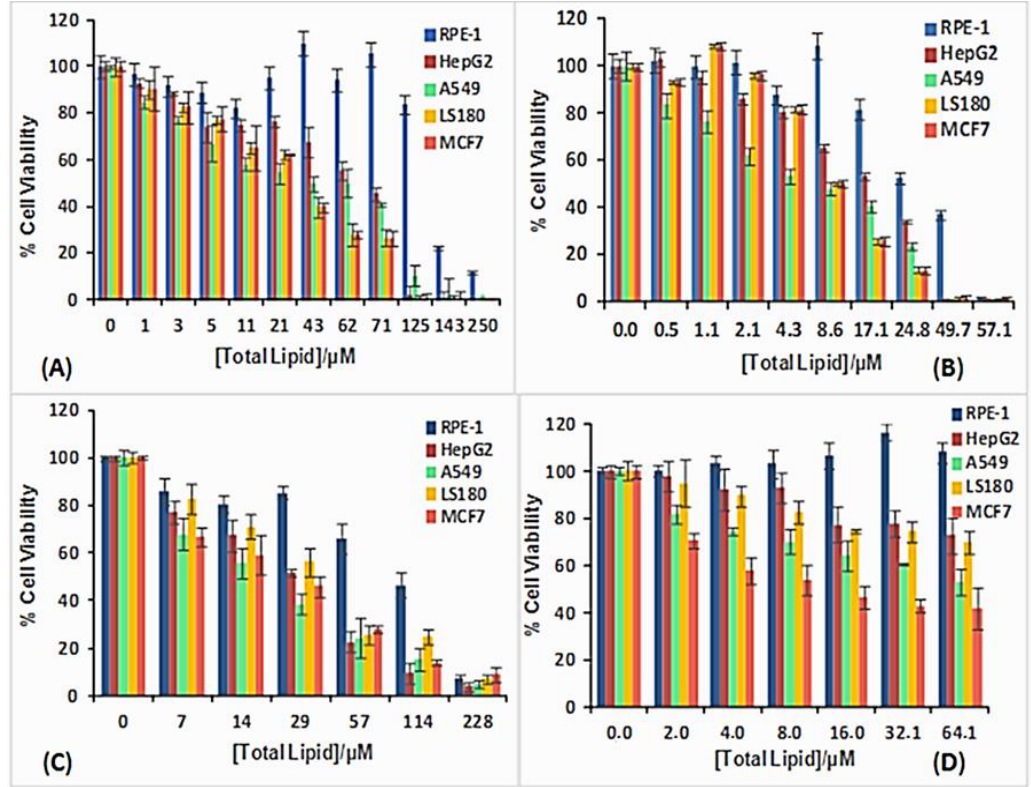
Figure 8. Cell viability of RuC11C11- and RuC19C19-based liposomes in different cell lines: ( A ) RuC11C11 α = 0.2, ( B ) RuC11C11 α = 0.8, ( C ) RuC19C19 α = 0.2, ( D ) RuC19C19 α = 0.8.